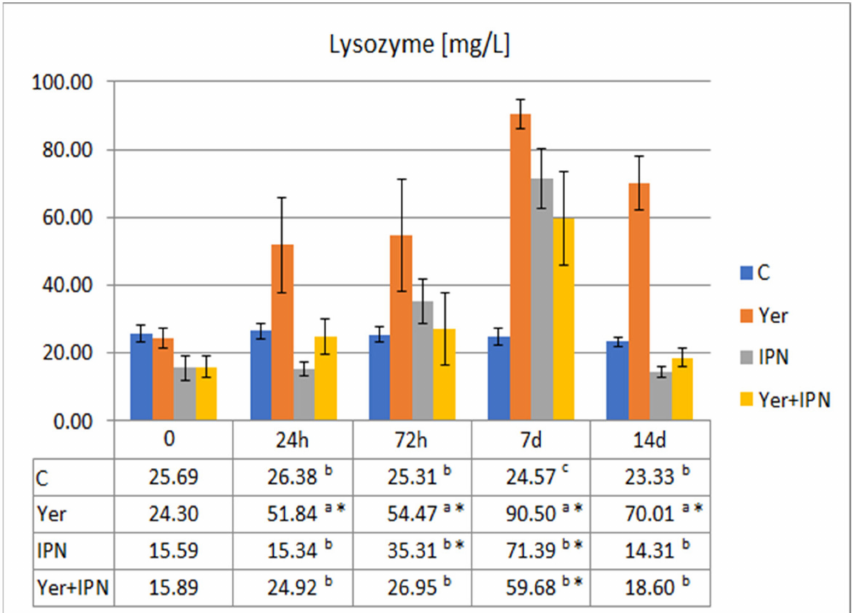
Figure 13. Mean values and standard deviation of lysozyme activity over the course of the second experimental infection. *—statistically significant differences compared to the day 0 values within a given group ( p ≤ 0.05); a, b, c —statistically significant differences between the groups on a given sampling day ( p ≤